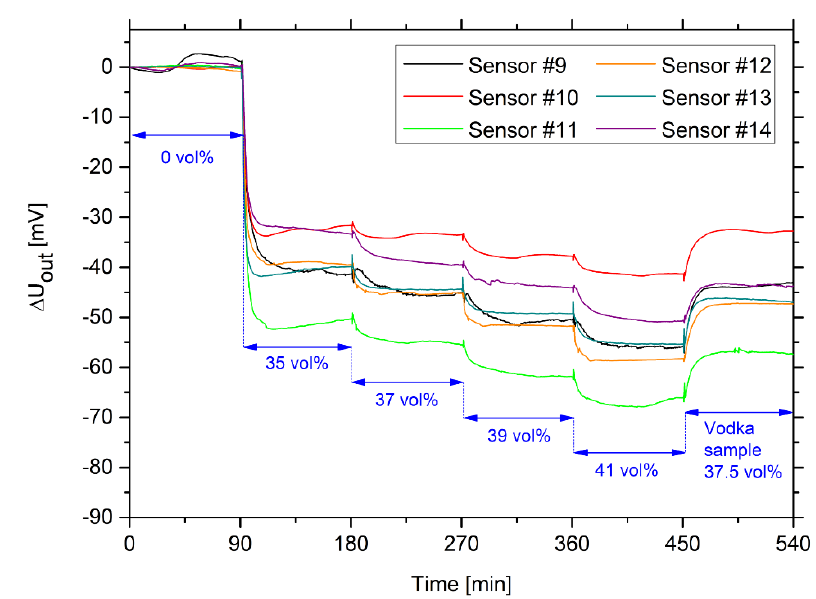
Figure 7. Time-dependent change in output voltage for six hydrogel-based sensors in ethanol–water mixtures with defined ethanol concentrations (between 35 and 41 vol% ethanol) for the preparation of calibration curves. At the end of the experiment, a vodka sample (“Wodka Gorbatschow” with 37.5 vol% ethanol) was measured to calculate the ethanol concentration of the vodka using the calibration curves.